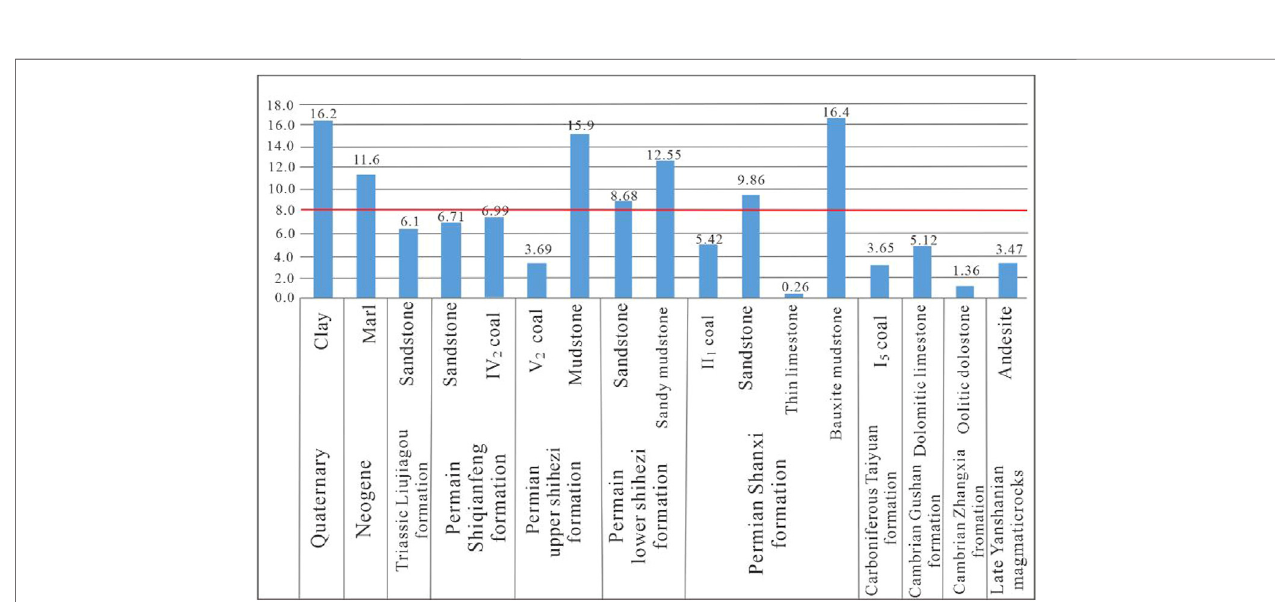
FIGURE 5 | Thorium content in the different strata